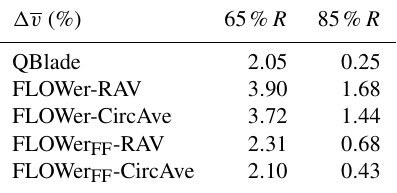
Table 7. Relative differences between the experiment and the differ- ent simulation results of the averaged on-blade velocity with respect to the undisturbed velocity at the probe positions for CaseBASE.